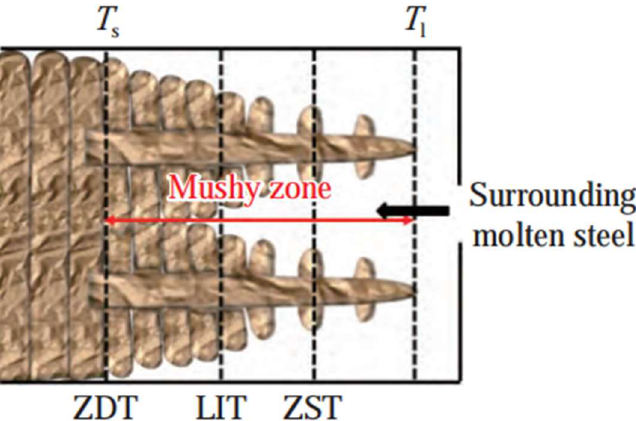
Figure 8. Temperature distribution at the solidification front in the bloom. When the cumulative strain in the temperature brittleness interval exceeds the critical strain, the solidification front will produce internal cracks [41]. The molten steel in the liquid phase zone has good fluidity. The filling zone can be filled with molten steel in time [42]. Therefore, the range from ZDT to LIT in the solidification front is prone to cracks. In this paper, the temperature range of the high crack area of the bearing steel is from the solidus to 1355 ◦ C. Cai [43] studied the critical strain solution criterion for internal cracks in the solidification front, as shown in Figure 9 [44], which is the relationship between carbon equivalent and critical strain. bloom to be less than 0.4% in the solidus to 1355 temperature range, the solidification front will not crack.